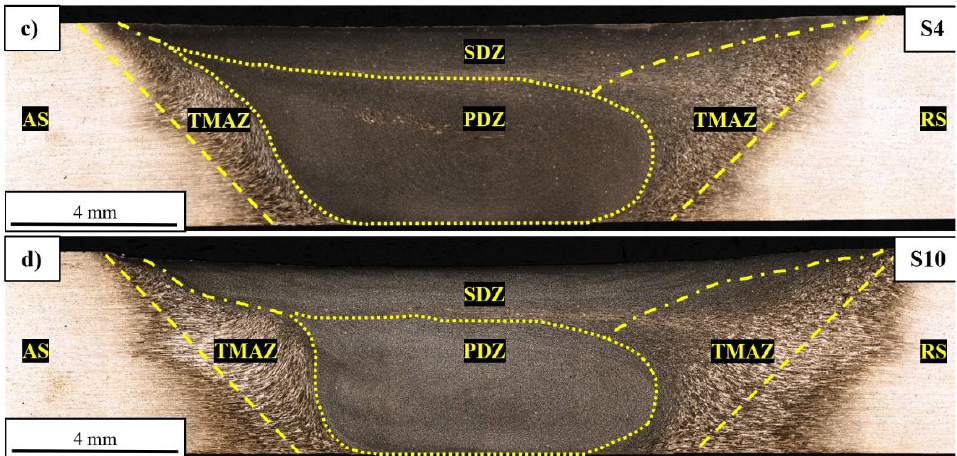
Figure 6. Macrostructural images of joints F4 ( a ), F10 ( b ), S4 ( c ) and S10 ( d ), together with estimated localizations of the SDZ, PDZ and TMAZ. Retreating (RS) and advancing side (AS) are marked on the images.